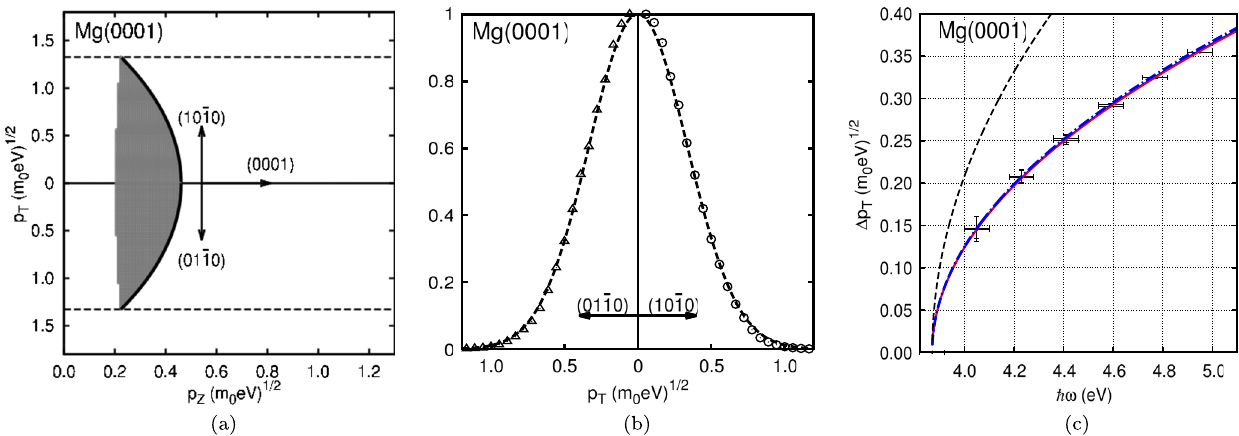
FIG. 1. Mg(0001) photoemission analysis for ℏ ω ¼ 4 . 75 eV. (a) Crystal momentum map of the electronic states (shaded regions) below the Fermi level (solid line) that may photoemit within p crystal directions; (b) Transverse momentum distributions of the photoemitted electrons in the ( fits are guides to the eye); (c) Incident photon energy dependence of the rms transverse momentum Δ p → 0 (data points with solid red line fit; Δ p T e Δ p ð ℏ ω Þ from Refs. [14] and [15] (dashed T